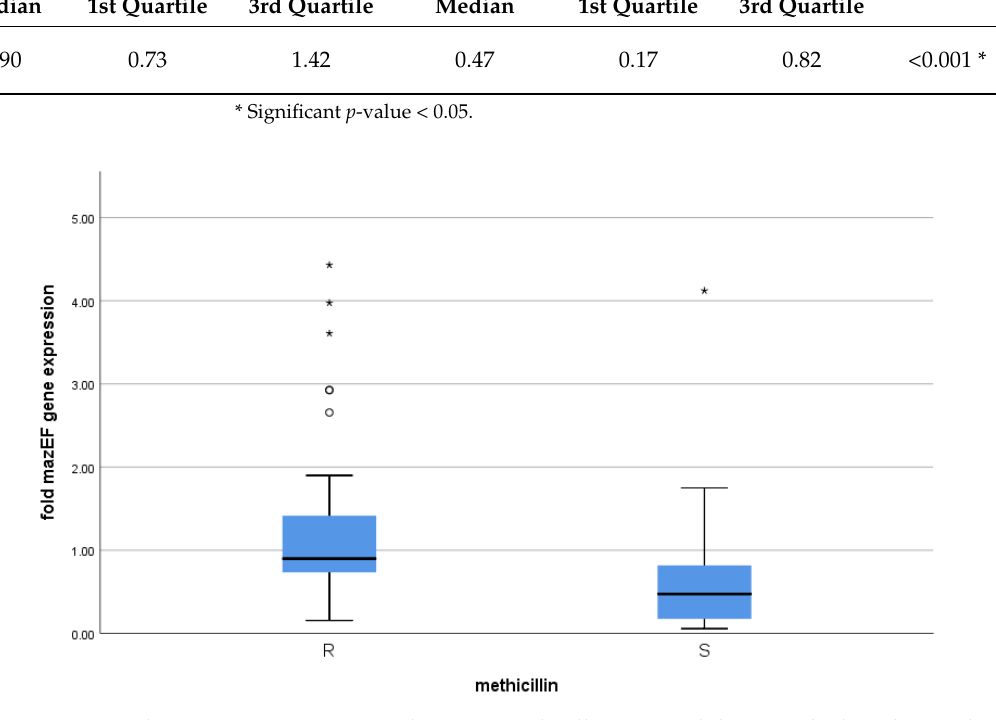
Figure 3. The mazEF expression in relation to methicillin susceptibility. On the boxplot, circles ◦ represent outliers and stars * represent more extreme values.